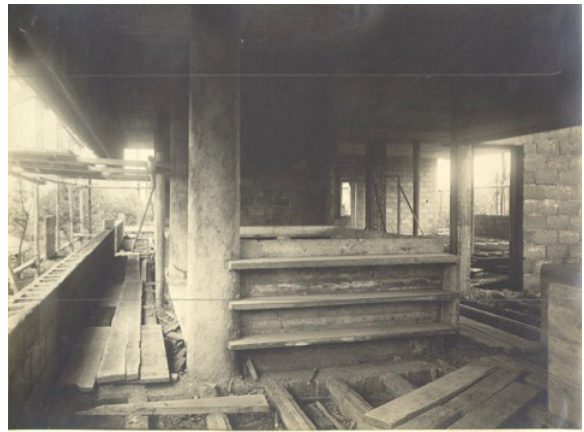
Figure 3. Internal view of the building site, first floor [FLC